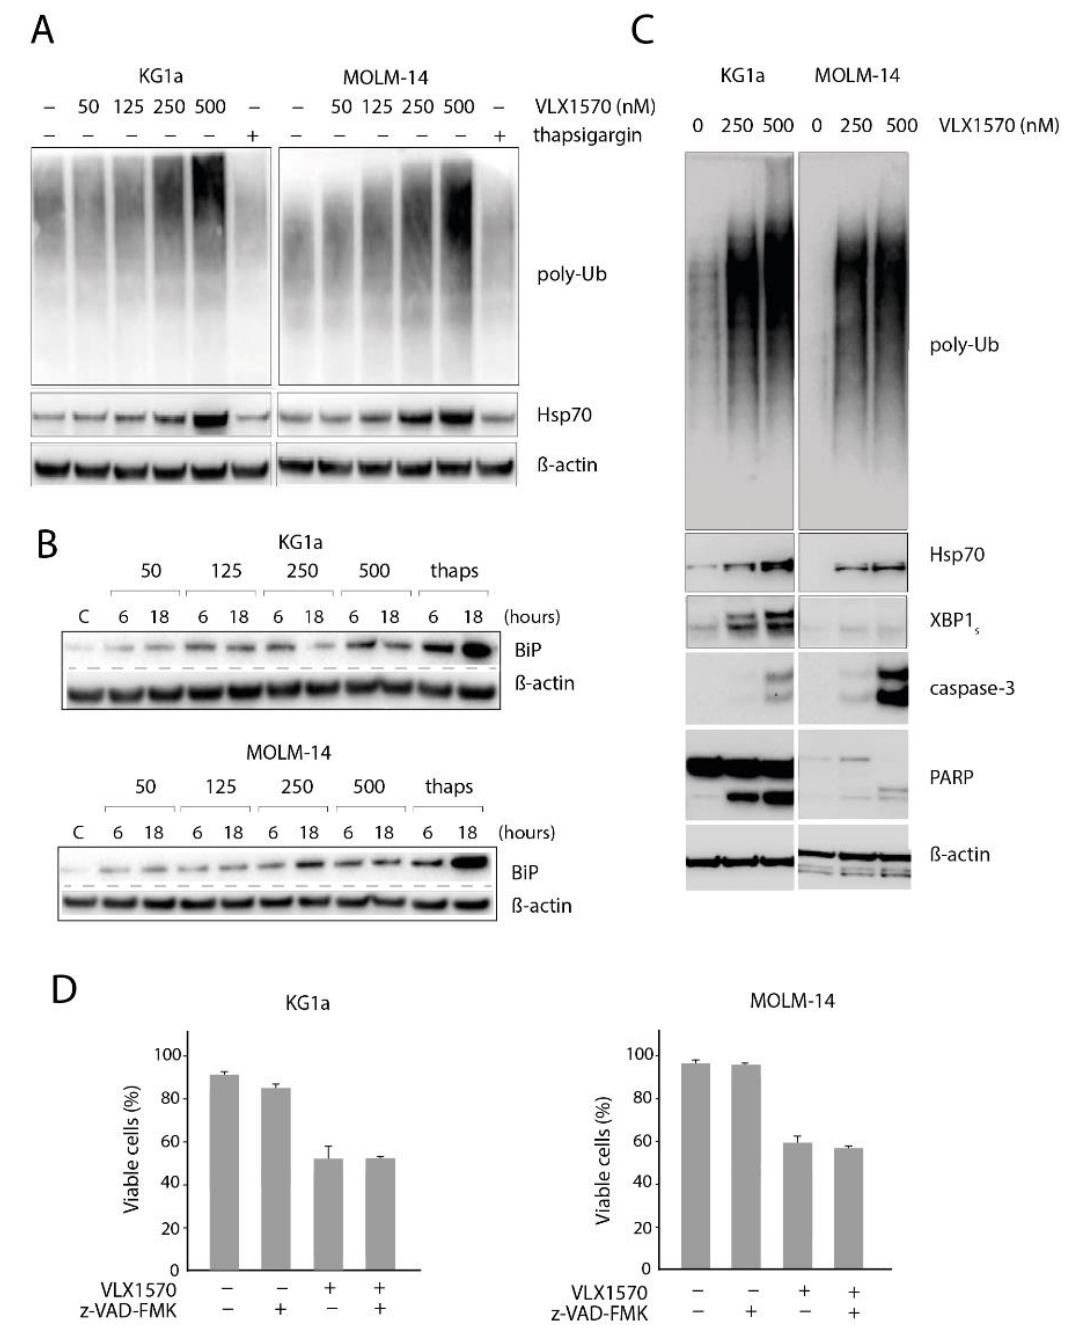
Figure 3. ( A ) Accumulation of polyubiquitinated proteins and increased in Hsp70 in KG1a and MOLM14 cells exposed to VLX1570; ( B ) time- and dose-dependent increased in Grp78/BiP in acute myeloid leukemia (AML) cells exposed to VLX1570; thaps: thapsigargin; ( C ) VLX1570 induction of proteotoxic stress and ER stress; ( D ) the loss of cell viability is not affected by the pan-caspase inhibitor z-VAD-fmk (10 μM). Cells were exposed to 0.35 μM VLX1570 for 48 h, and cell viability was determined by acridine orange/propidium iodide staining. The barplots are the average of three replicates of a single experiment. Error bars represent one standard deviation. The experiment was repeated with similar results.